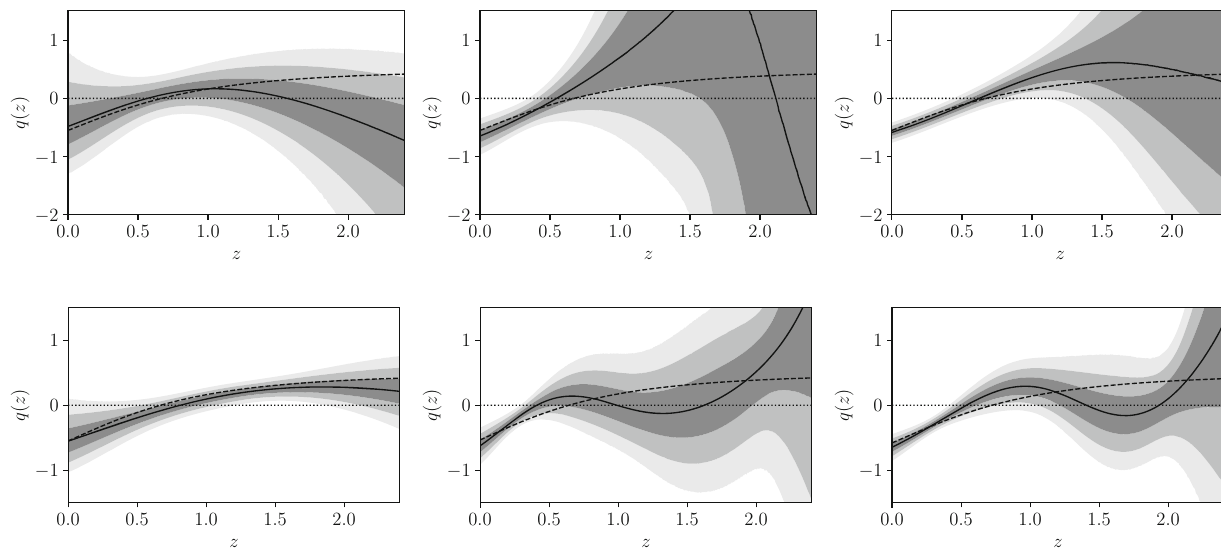
Fig. 9 Plots for q ( z ) reconstructed from CC data (top left), Pantheon data (top middle), CC + Pantheon data (top right), CC + BAO data (bottom left), Pantheon + BAO + CMB data (bottom middle), and CC + Pantheon + BAO + CMB data (bottom right). The solid black line is the “best fit” and the black dashed line represents the (cid:2) CDM model with (cid:12) m 0 = 0 . 3